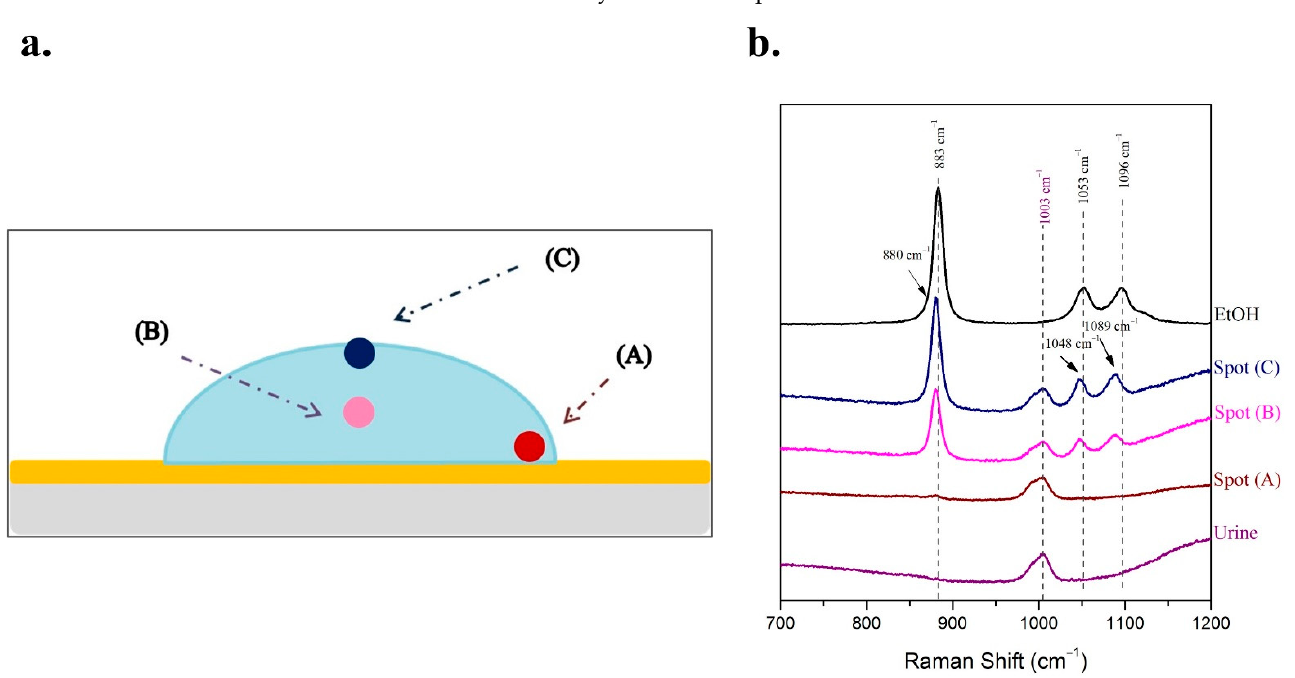
Figure 2. The method of sample droplet on a glass microscope slide coated with a gold highly reflec- tive substrate was applied for the determination of 100 µ L/mL ethanol in human urine. ( a ) Schematic illustration of the focus on three different spots of the sample droplet; ( b ) the respective Raman spectra from the three different spots of the droplet were recorded.